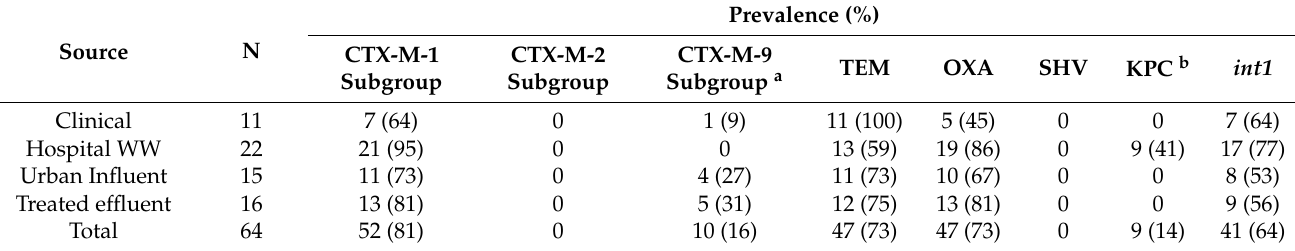
Table 1. Prevalence of β -lactamases and int1 genes among E. coli